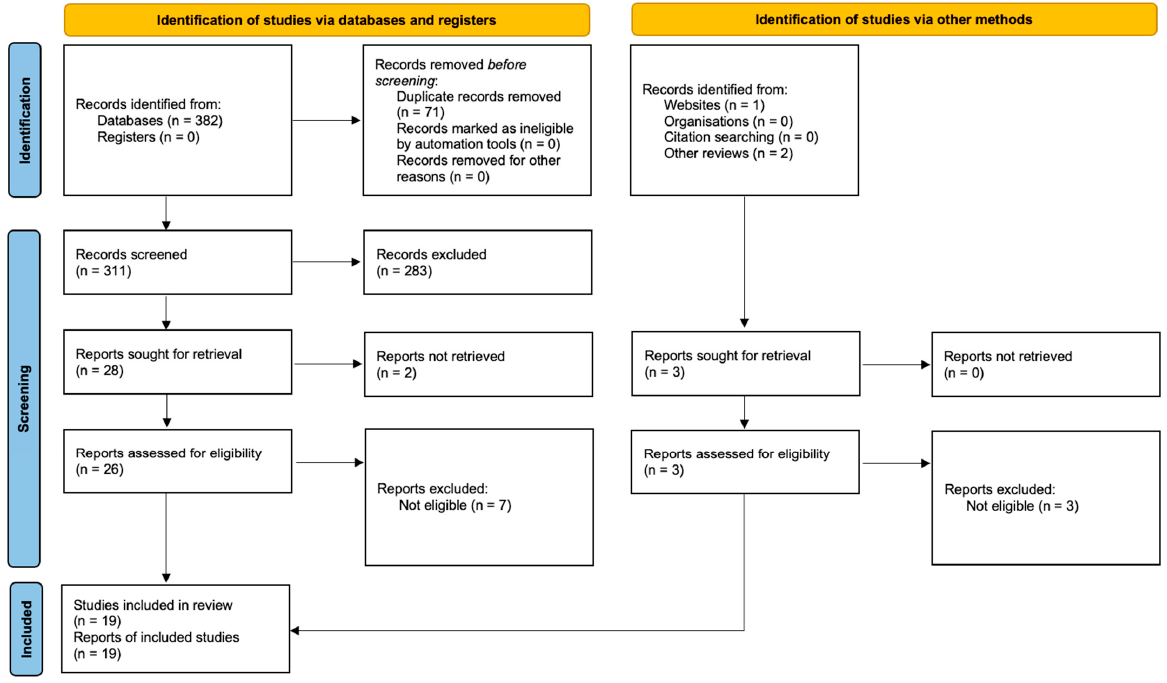
Figure 2. Modified Prisma Flow Diagram [54] for the clinical trials on prebiotics, probiotics and synbiotics in patients with major depressive disorder included in the systematic review.